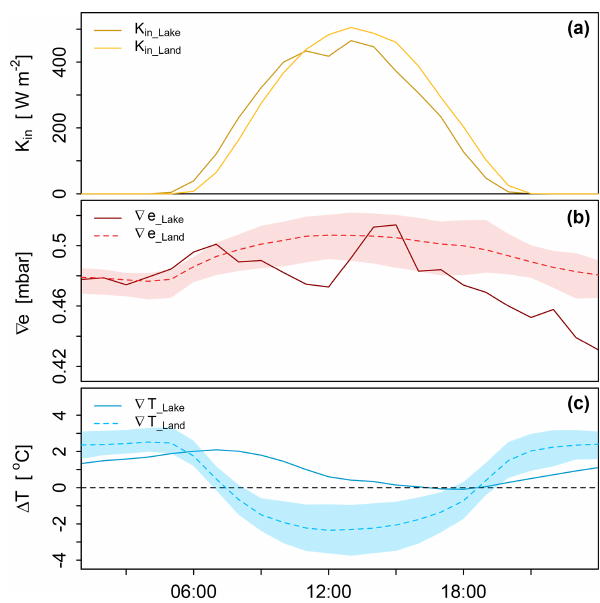
Figure 1. Illustration of the mean diurnal cycle of turbulent ex- change over land compared to open water. Lake data are ob- tained above Lake Flevo during the Flevo experiment in Au- gust/September 1967. Data above land originate from observations in Cabauw and are based on 10 August/September months of con- secutive years (2009–2018): the solid line represents the average and the shaded bands represent the range in these 10 years. The top panel presents the diurnal cycle of global radiation (a) . The middle and bottom panels display the vertical gradients of vapour pressure and temperature for the lake and land surface ( b and c ,